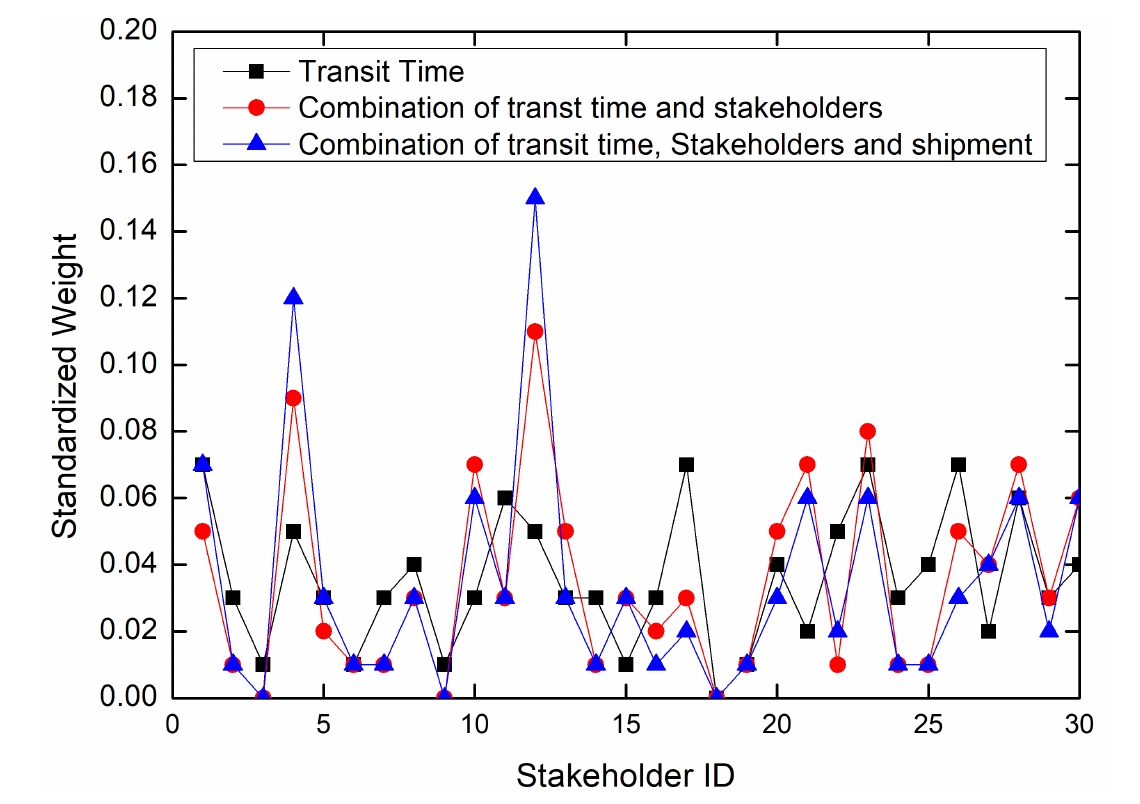
Figure 6. Network Performance